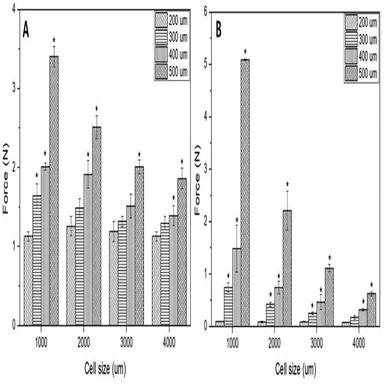
Evaluation of mechanical properties of final product (A: Radial force with cell size and fiber diameter, B: Axial force with cell size and fiber diameter) (reference dimension of scaffold: Φ 9–85 mm) (\p < .01 compared with the 200 μm group).